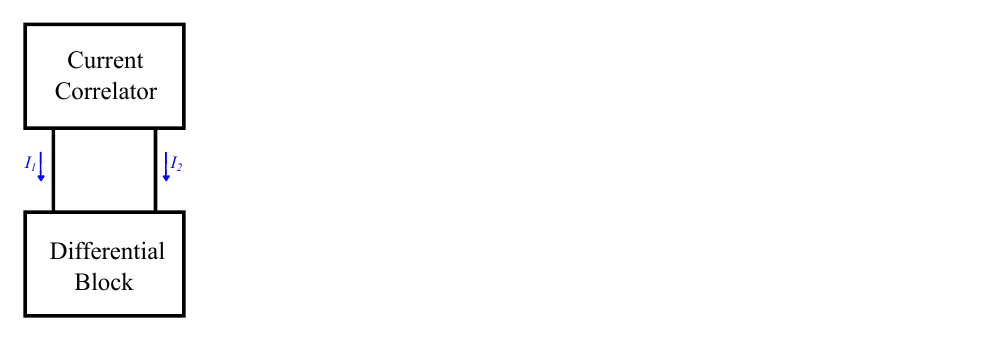
Figure 3. Block diagram of a generic Gaussian function circuit (inspired by Delbruck’s Simple Bump).